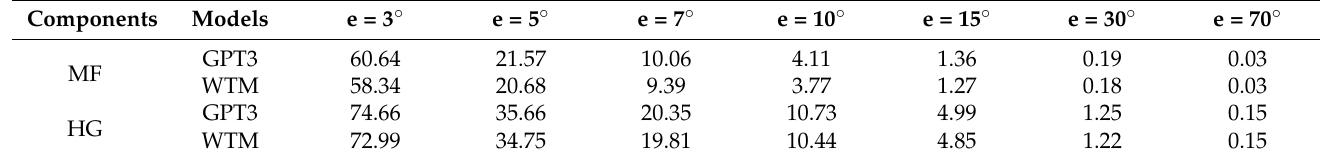
Table 2. Model MAE (mm) at different elevation